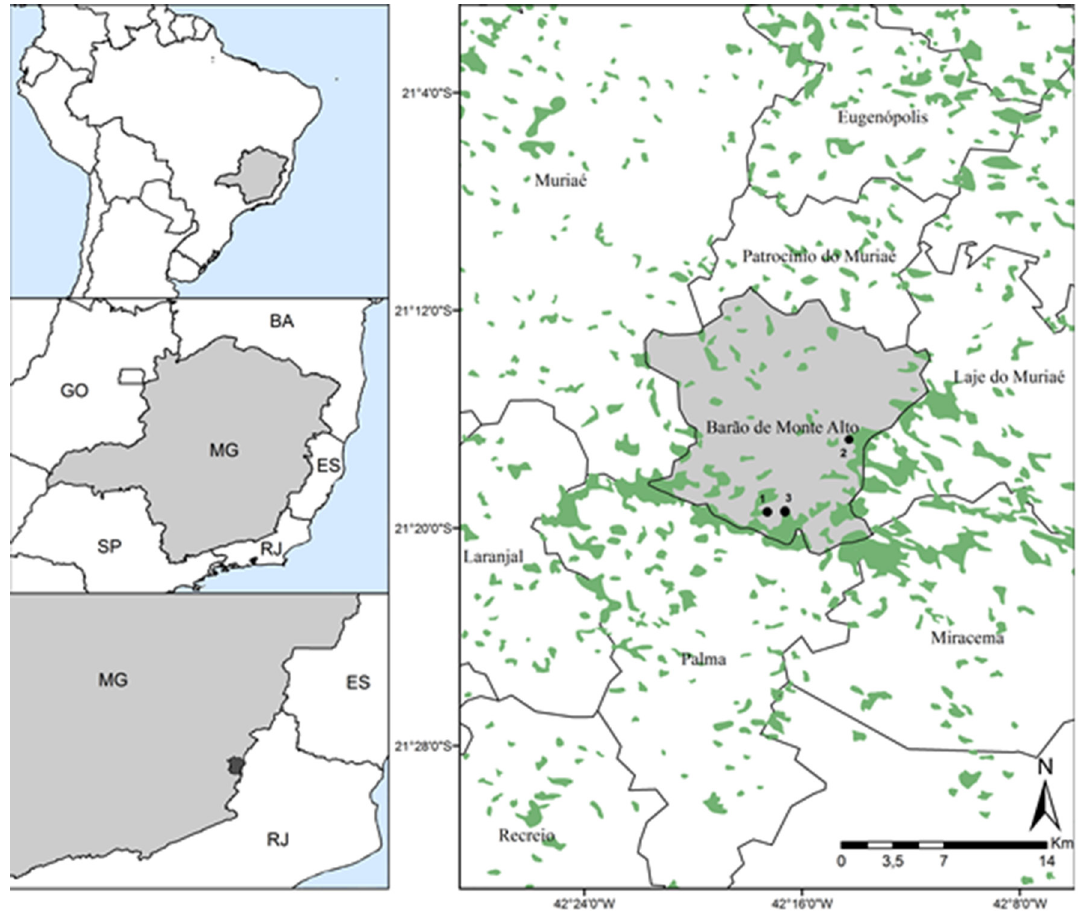
Figure 1. Location of the Municipality of Barão de Monte Alto, State of Minas Gerais, Brazil. Points: ( 1 ) Area A, ( 2 ) Area B and ( 3 ) Area